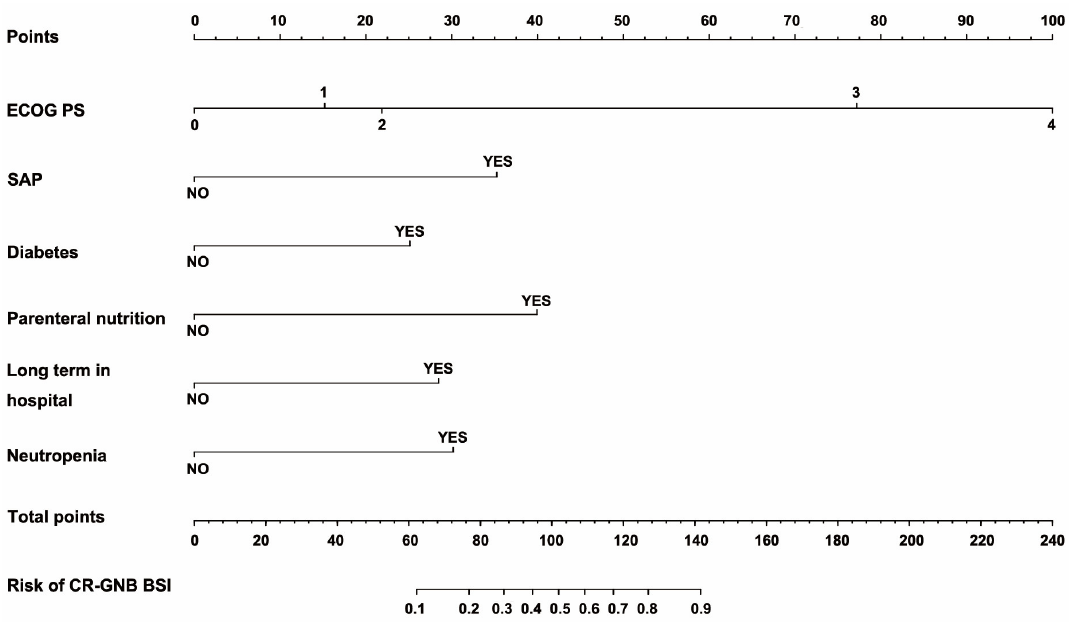
Figure 2. Nomogram for predicting the probability of secondary CR-GNB BSI for carrier patients in GED. Abbreviations: ECOG (Eastern cooperative oncology group score); SAP (severe acute pancreatitis); CR-GNB (carbapenem–resistant Gram–negative bacteria); BSI (blood stream